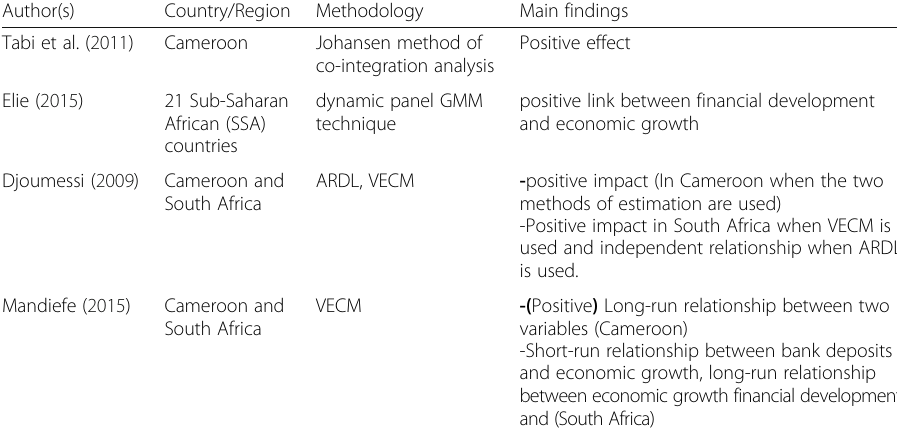
Table 2 Financial development and economic growth in Cameroon